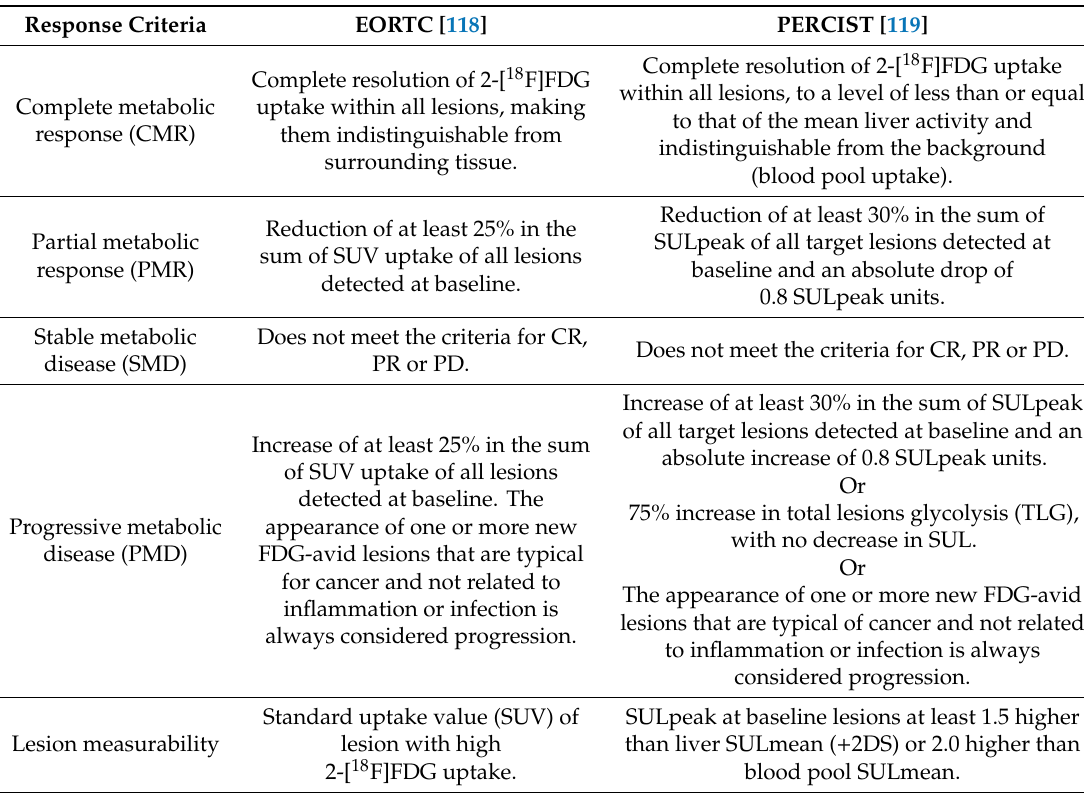
Table 5. Main PET scoring system for functional response criteria in solid